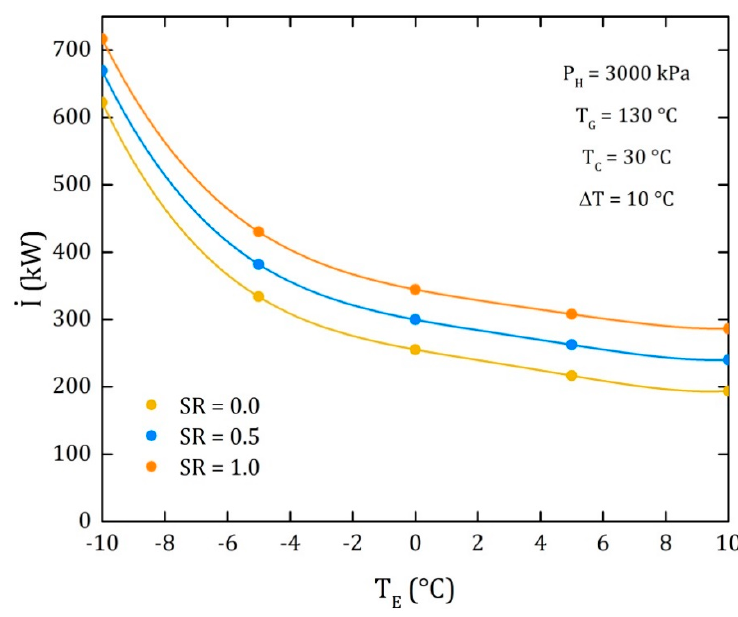
ff erent values of